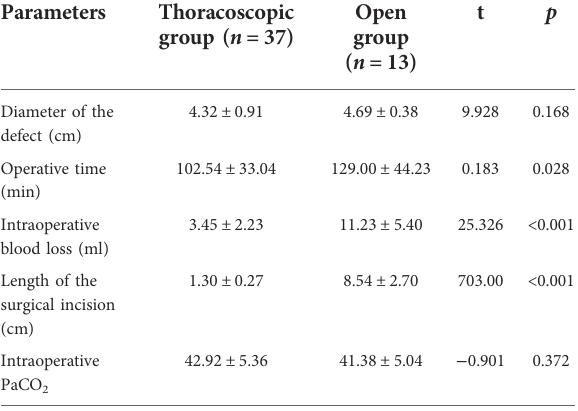
TABLE 2 Comparison of the intraoperative parameters.